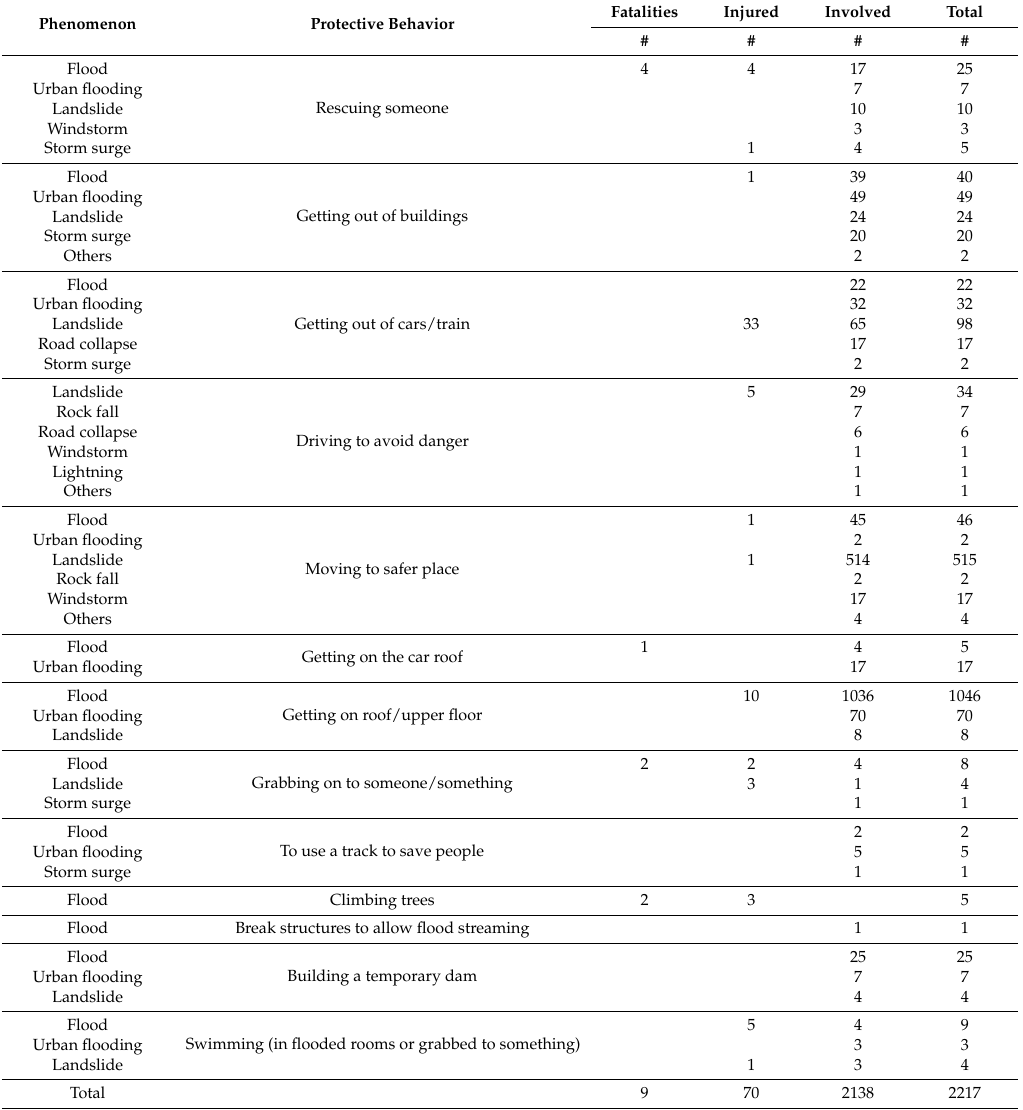
Table 10. Types of phenomena and protective behaviors.